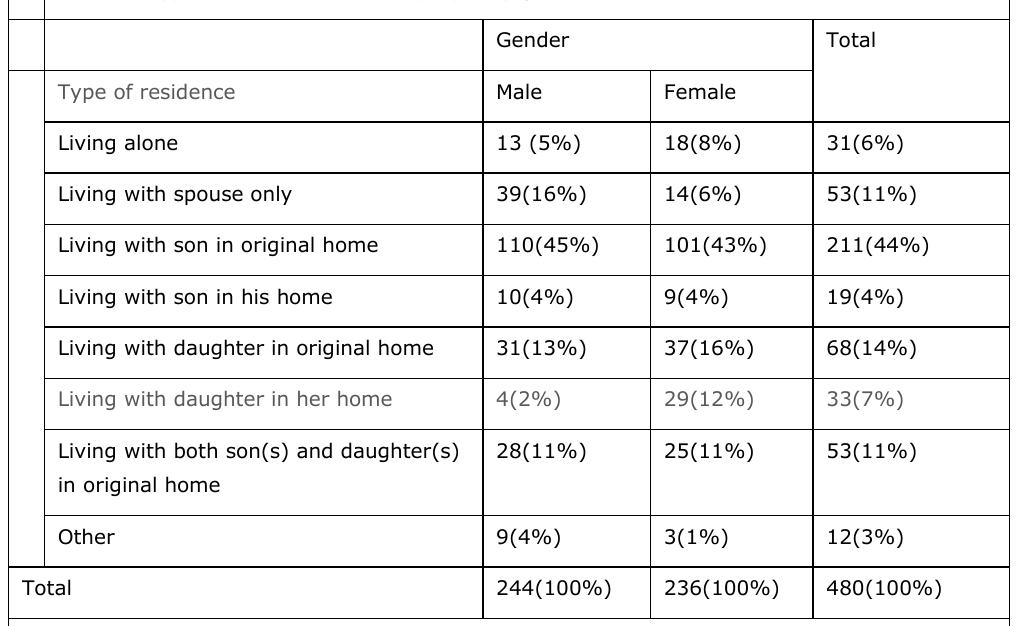
Table 7: Type of residence of older people by gender Gender